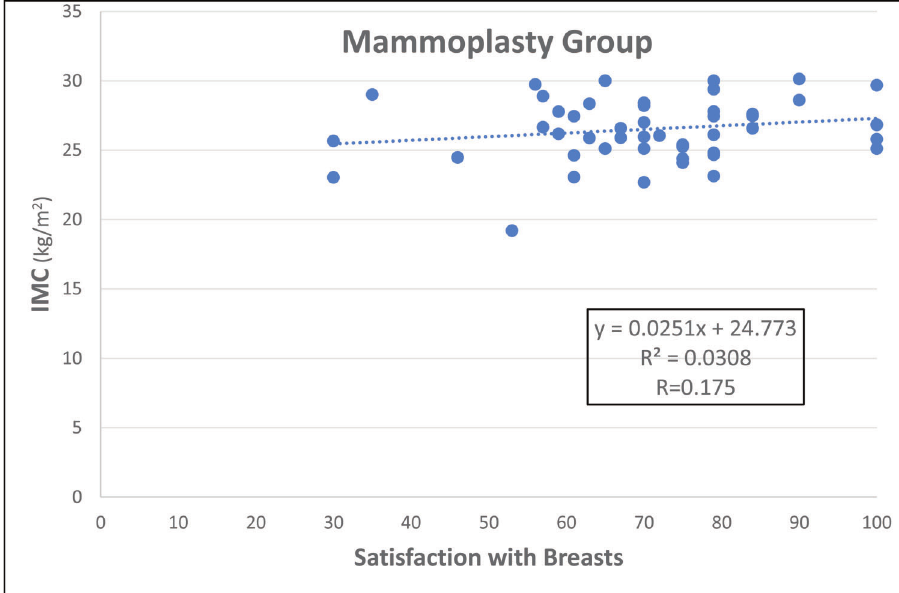
Figure 4 - Simple linear regression for BMI (independent variable) and ‘‘ Satisfaction with breasts ’’ (dependent variable) in the MG.